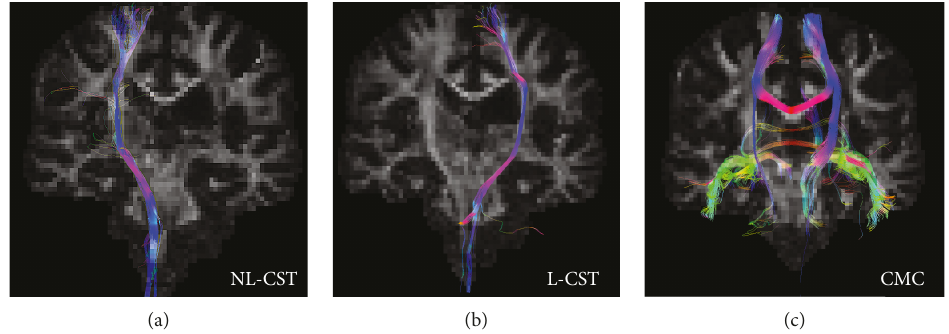
Figure 8: Subject-speci fi c examples of white matter tractography. Fractional anisotropy (FA) and overlaid red-green-blue-colored FA tractography: red (left/right), green (anterior/posterior), and blue (superior/inferior). Examples of DW-WM tracts from the (a) nonlesioned corticospinal tract (NL-CST), (b) lesioned corticospinal tract (L-CST), and (c) constrained motor connectome (CMC) for a motor practice responder in the SMc-cTBS